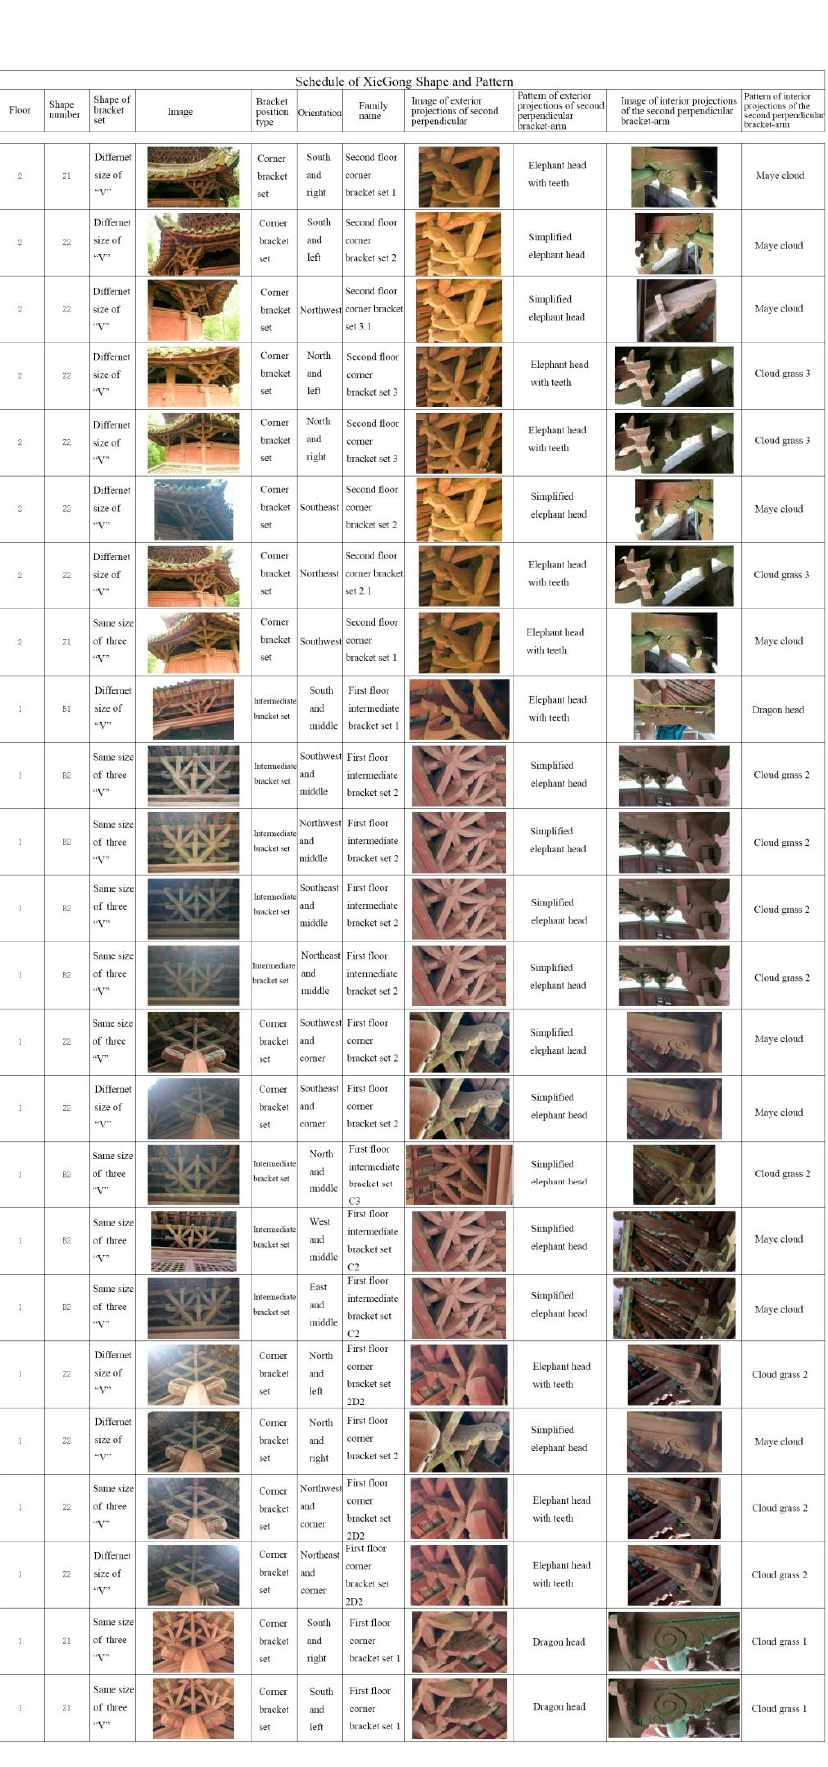
Figure 20. Schedule of Xiegong shape and pattern.